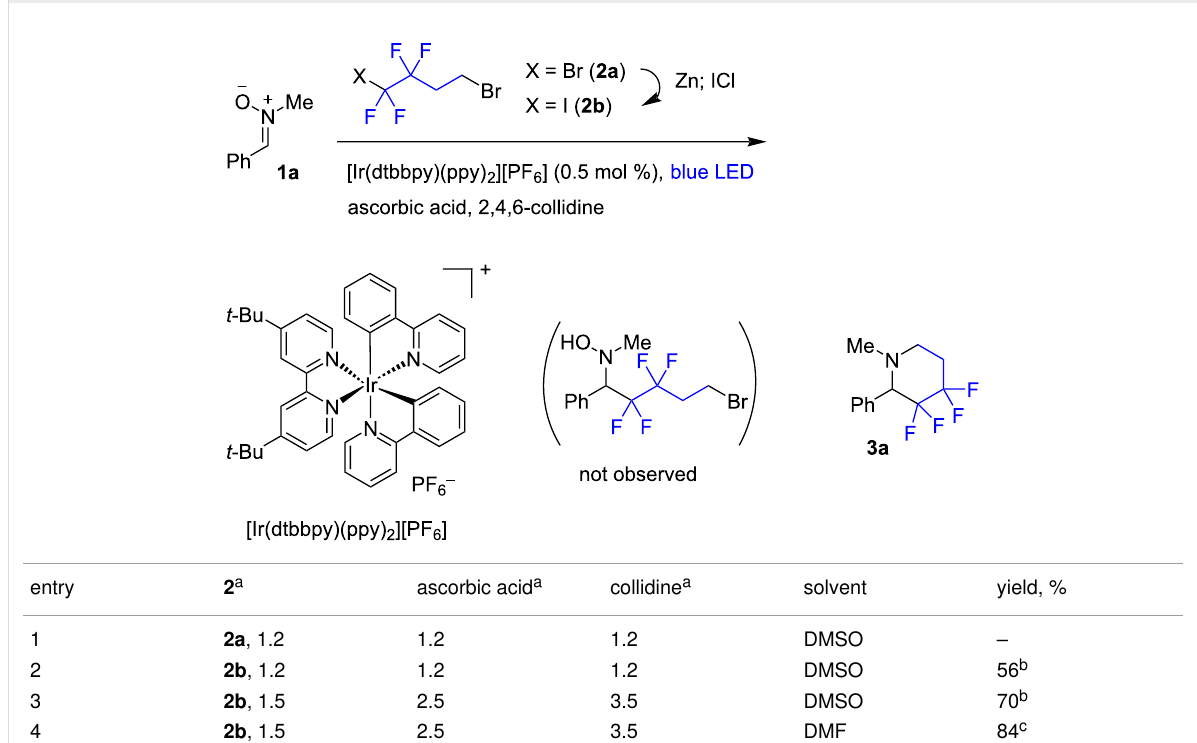
Table 1: Optimization studies for the synthesis of 3a